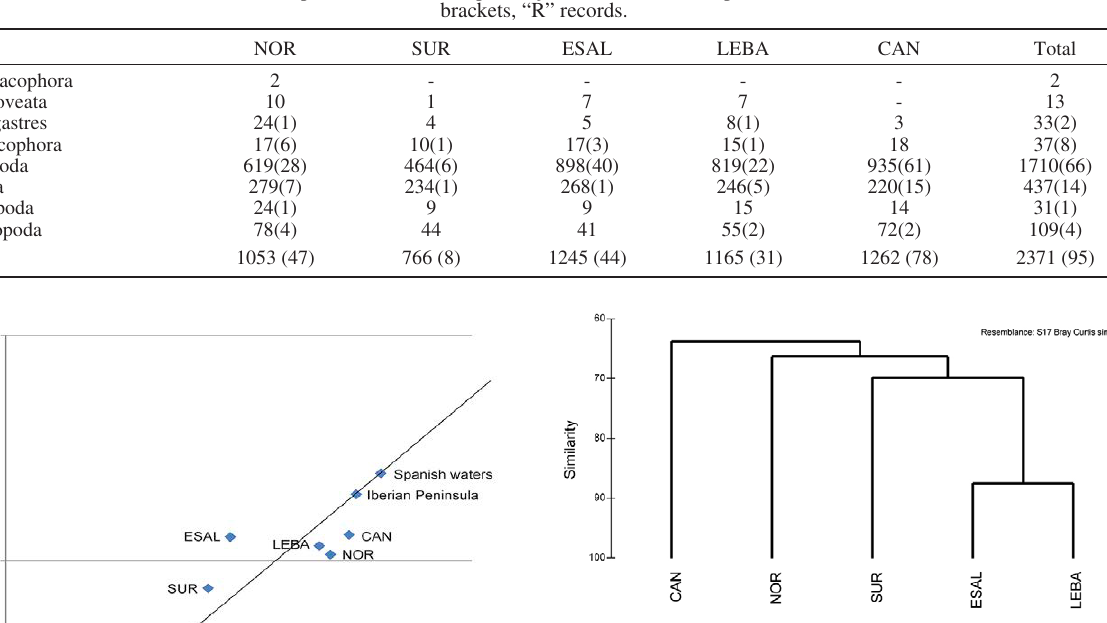
Fig. 3. – Similarity in species composition between the five demar- cations, based on Bray-Curtis index.